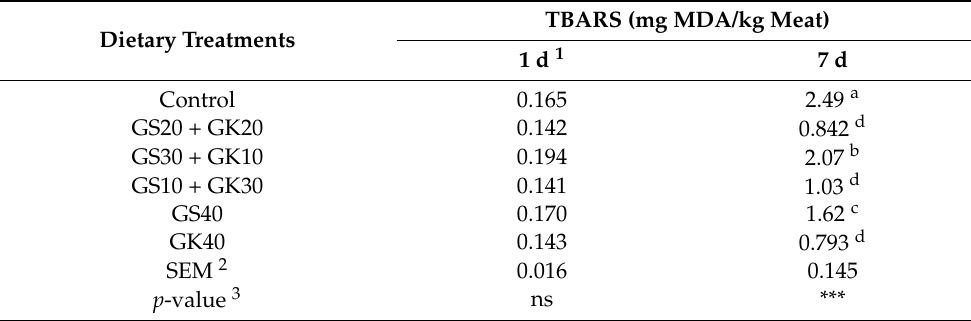
Table 5. Effect of grape seed (GS) and grape skin (GK) meals added at different dietary concentrations (g/kg) on stored thigh meat lipid oxidation in broiler